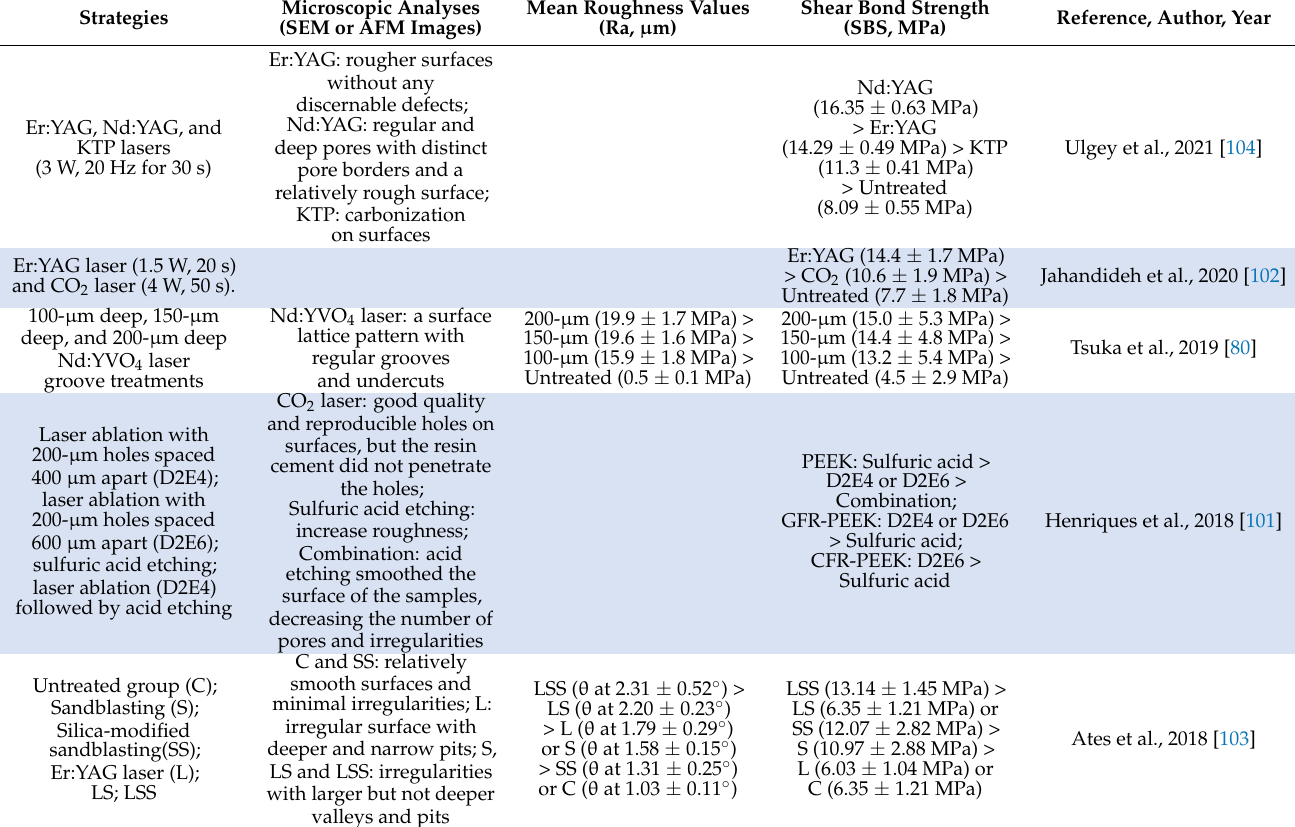
Table 5. The application of laser treatment for the improvement of PEEK adhesion behavior. Mean Roughness Values Shear Bond Strength Strategies Microscopic Analyses (SEM or AFM Images) (Ra, µ m) (SBS,